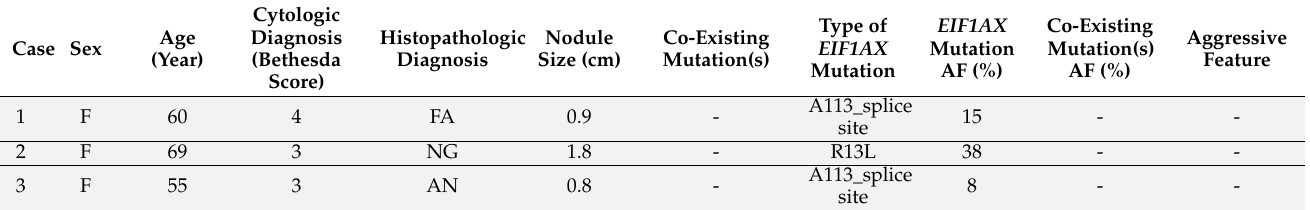
Table 1. Clinicopathological features of EIF1AX -mutated cytologically indeterminate thyroid nodules by study